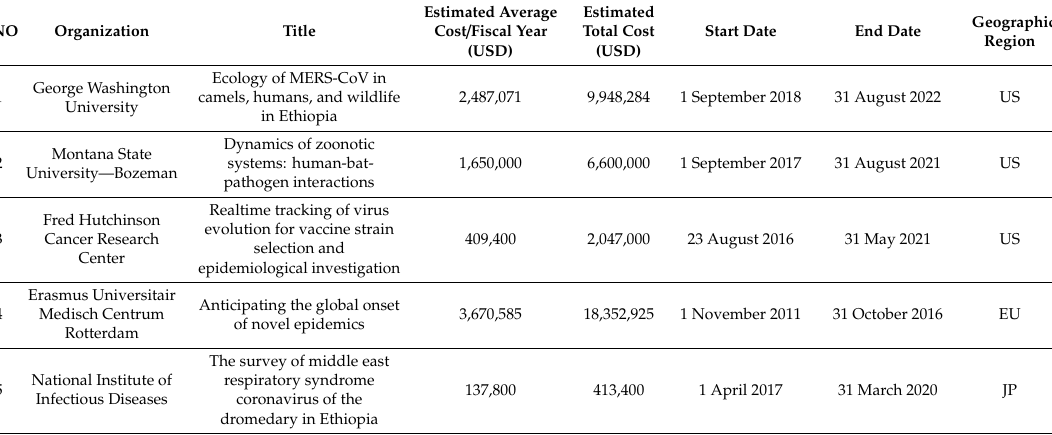
Ecology (Cluster